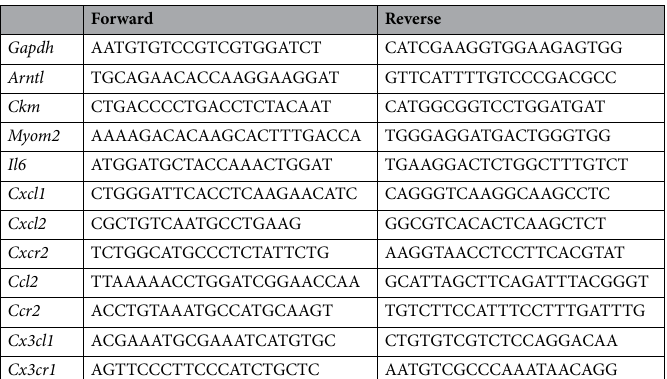
Table 1. The primers used in this